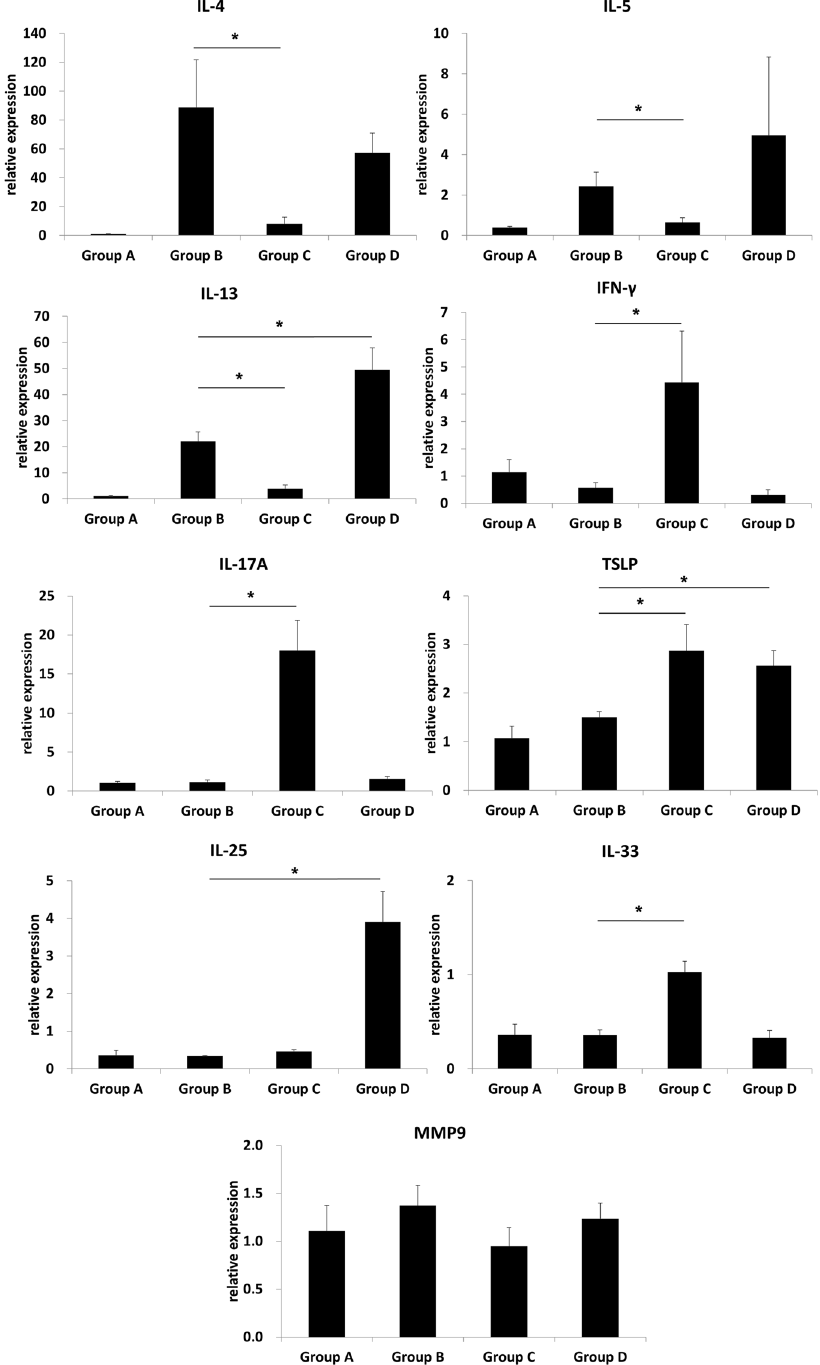
Figure 3. Comparison of the inflammatory cytokines profile of the nasal mucosa in different experimental groups. This figure was drawn using Microsoft’s PowerPoint 2016 (https ://www.micro soft.com). Group A: negative control, Group B: positive control, Group C: LPS stimulation, Group D: poly(I:C) stimulation. *P <